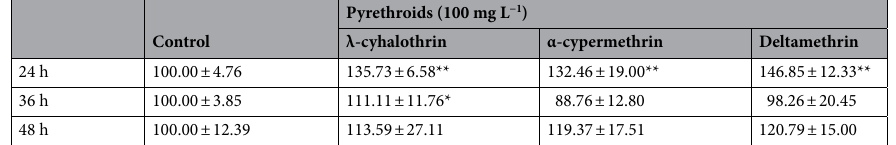
Table 1. Metabolic activity (%) of B. bassiana after 24, 36, and 48 h of culture with λ-cyhalothrin, α-cypermethrin, and deltamethrin. Data are means ± SD; all samples were prepared in triplicate, and the experiments were repeated twice. Results were tested by one-way ANOVA; significance: ** P < 0.01, * P < 0.05.